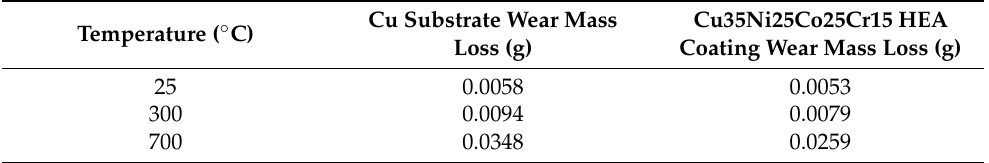
Table A4. Wear mass loss of the Cu35Ni25Co25Cr15 HEA coating deposited under a welding current of 150 A and pure Cu substrate at different